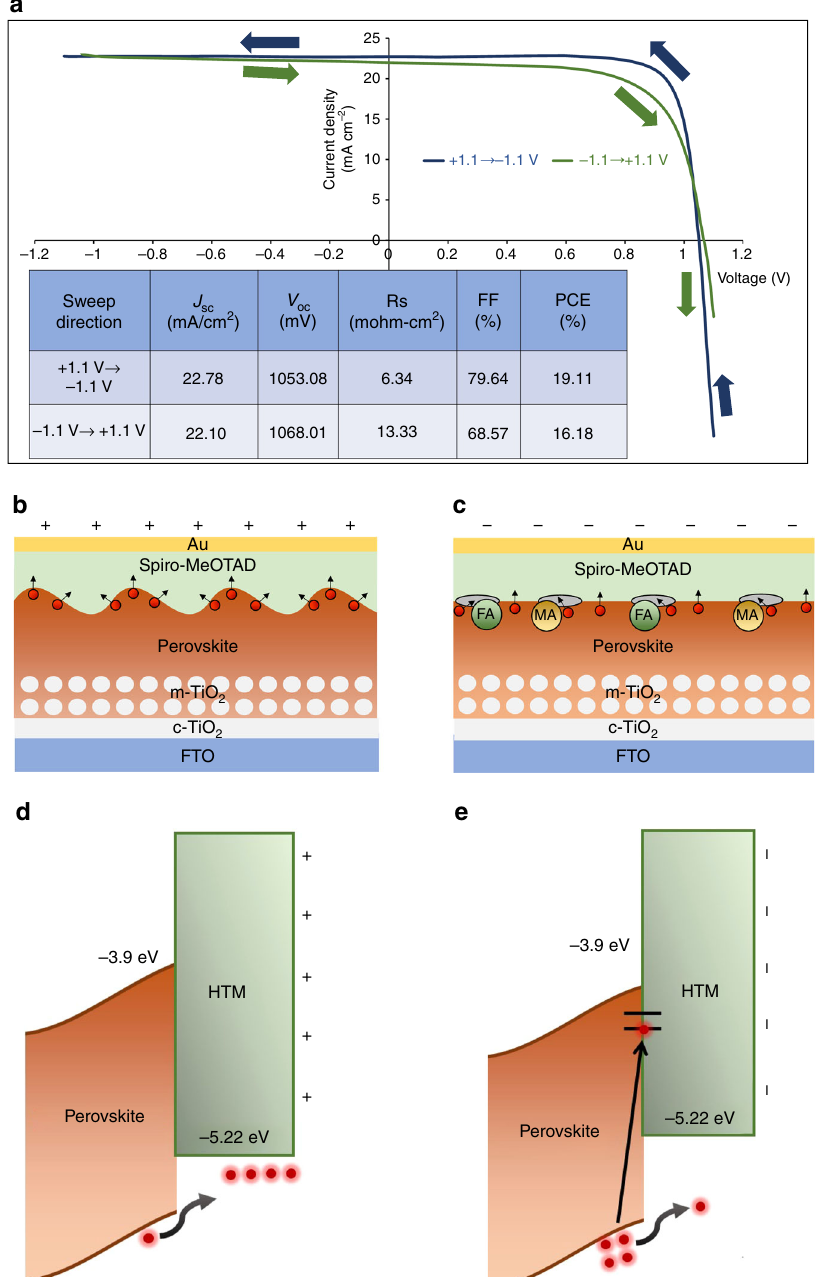
Fig. 6 Proposed mechanism of the I – V hysteresis caused by structural variations. a Forward bias ( + 1.1 to − 1.1 V) and reverse bias ( − 1.1 to + 1.1 V) I – V curves measured at a rate of 0.1 V s − 1 . Inset shows device performance parameters. Schematic illustration of perovskite surface when b positive bias and c negative bias are applied to the top surface. Corresponding band diagrams of perovskite/HTM interface when d positive bias and e negative bias is applied to the